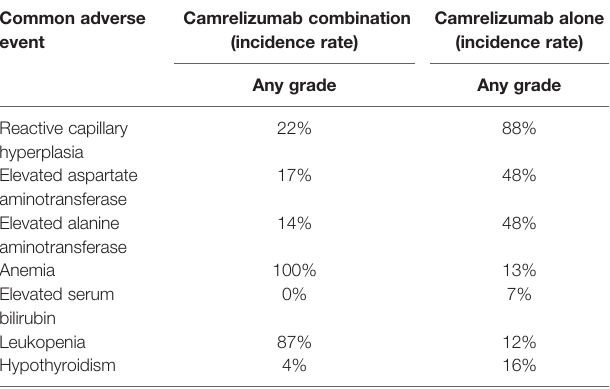
TABLE 2 | Comparison of the incidence of common adverse events (any grade) between camrelizumab alone and combination therapy.